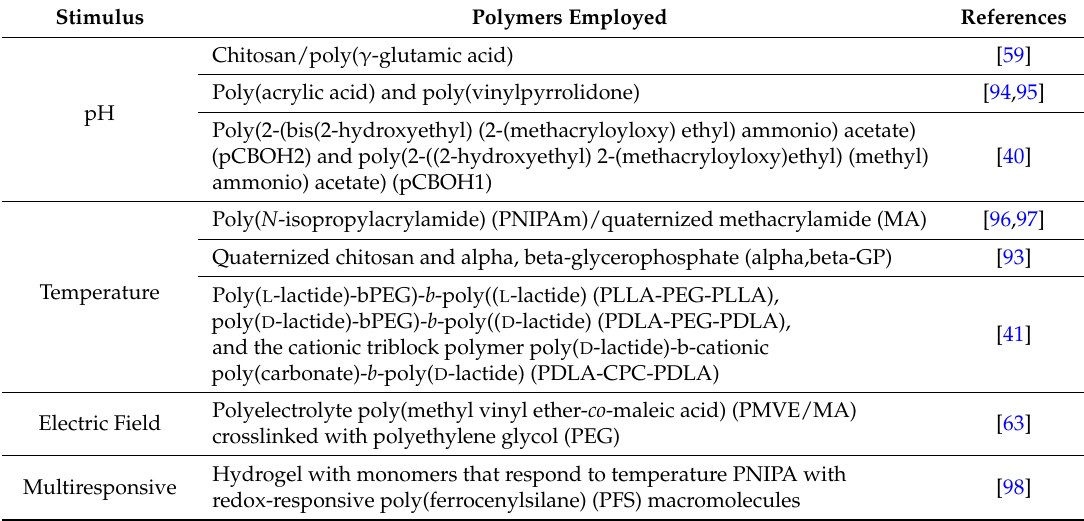
Table 2. Summary of the most relevant stimuli-responsive antimicrobial